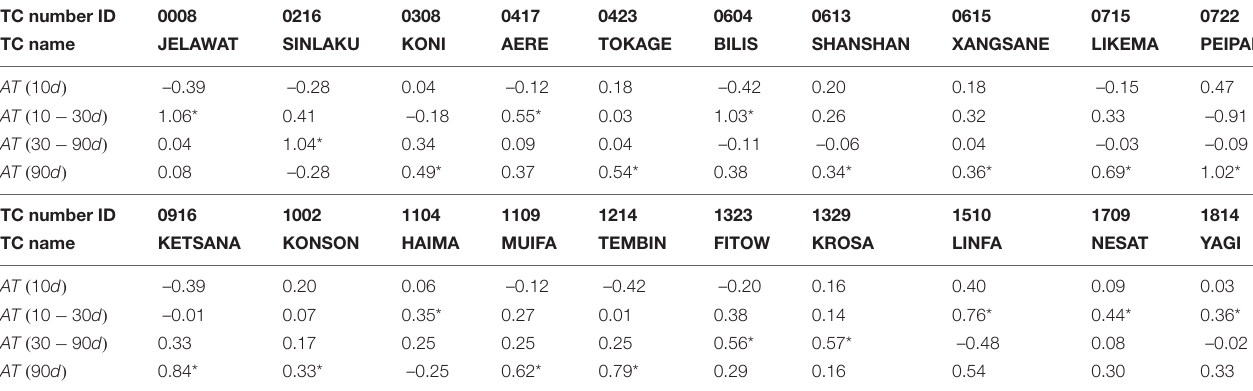
TABLE 4 | The mean AT value for the SLT cases associated with each wave mode averaging within the sudden track period.